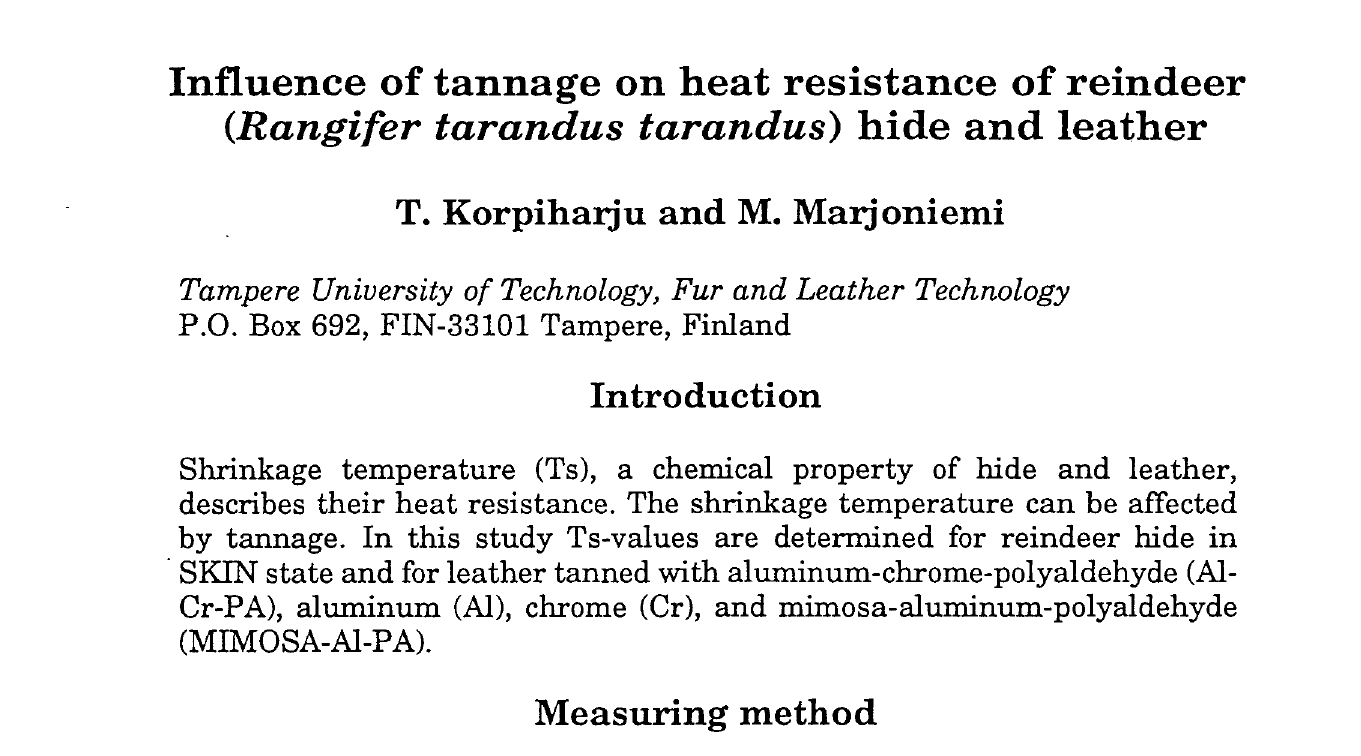
Table 1. Minimum and mean shrinkage temperature of different tanning states with standard